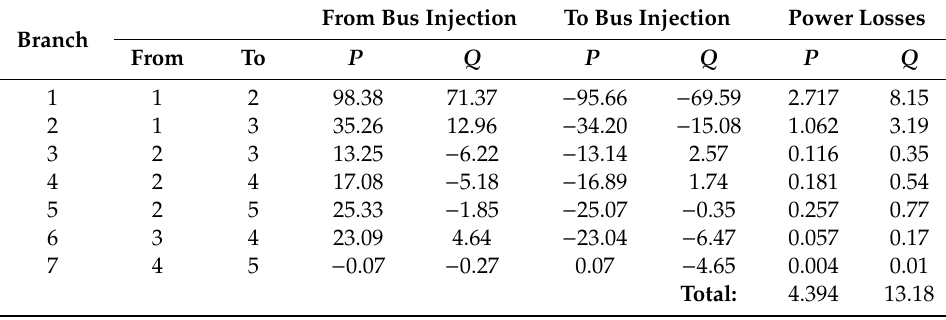
Table A4. Results of the mixed AC / DC PF calculations in Case 2. AC branch data.